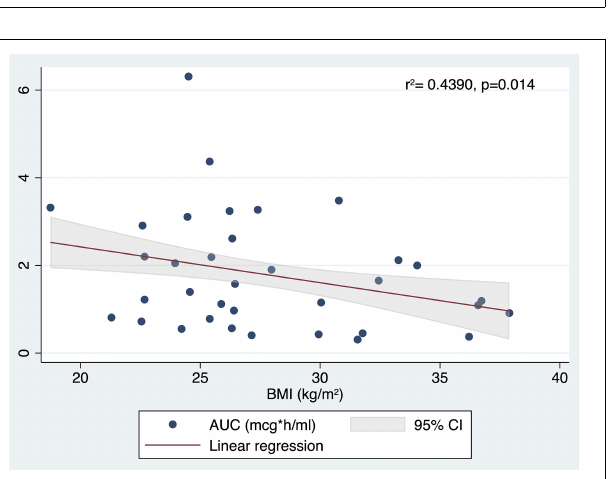
to set up the best-personalized approach. In particular, BMI emerged as the only predictor of t 1 / 2 in women and not in men.